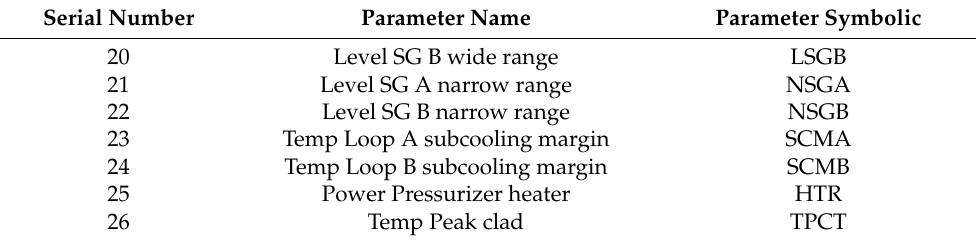
Figure 8. Loss value of the training dataset.